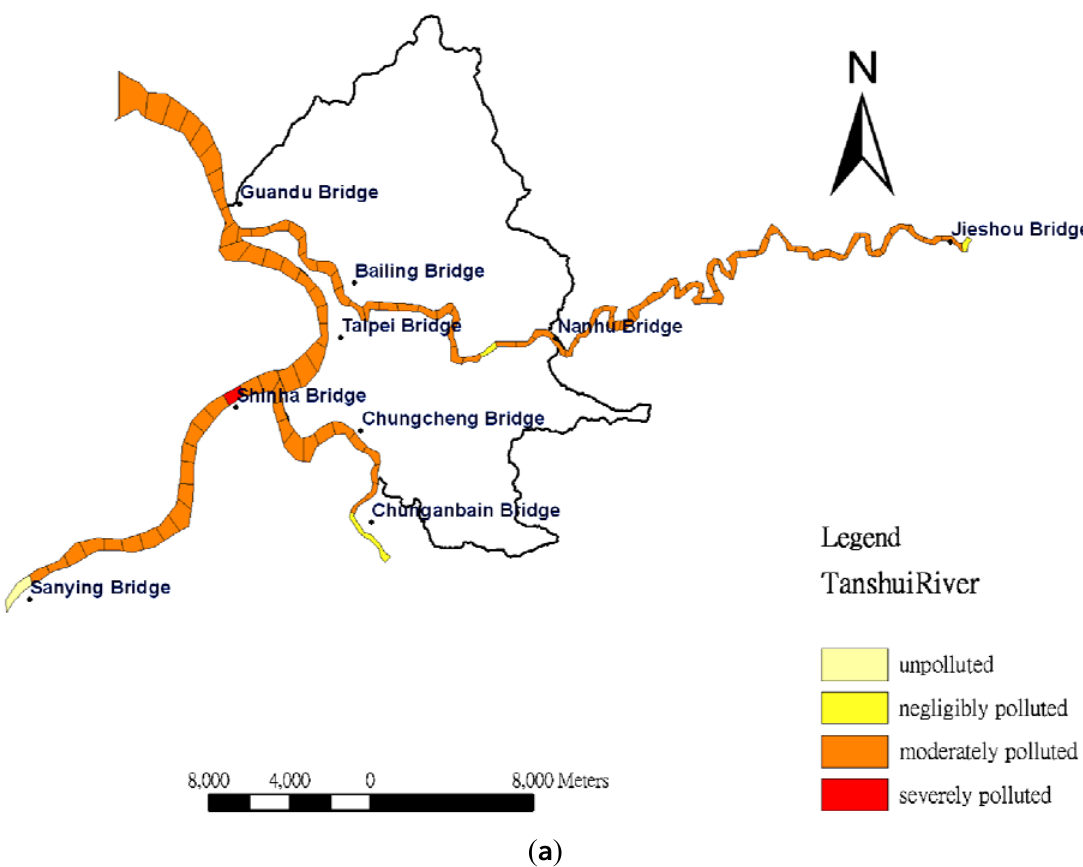
Figure 7. Spatial distribution of RPIs in the Tanshui River estimated by the ( a ) kriging and ( b ) IDW method. Data was obtained at 3 p.m. on 29 September